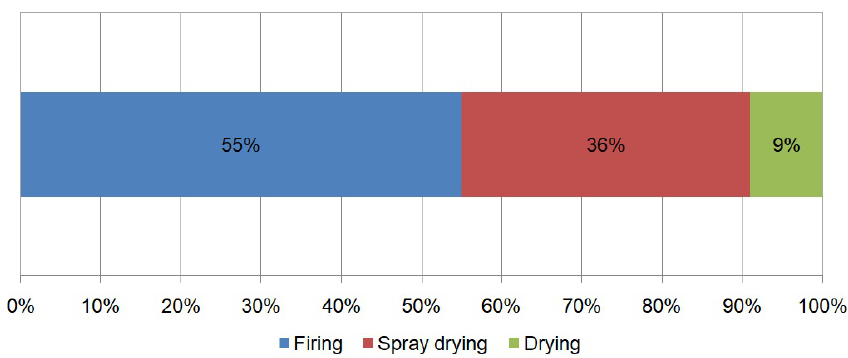
Figure 2. Breakdown of the main thermal energy consumption in ceramic tile production.